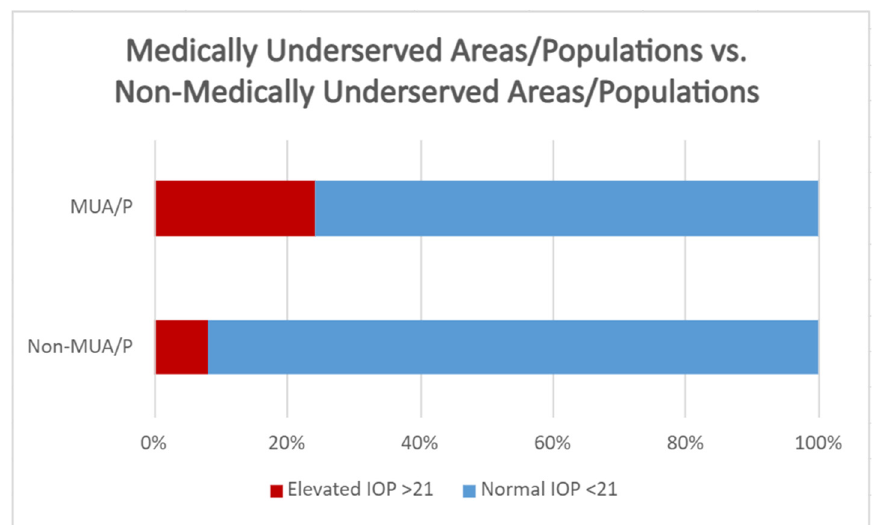
Figure 6. Percentage of IOP > 21 mmHg in MUA/Ps vs. non-MUA/Ps.